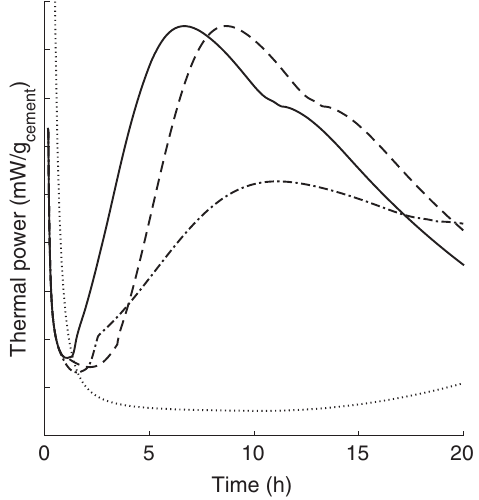
FIG. 1. Schematic illustration of how a calorimetric measure- ment of the hydration of a neat cement (solid line) can be changed by additions causing retardation (dashed line), lowered rate of the main reaction (dash-dotted line), or serious hydration disturb- ances (dotted